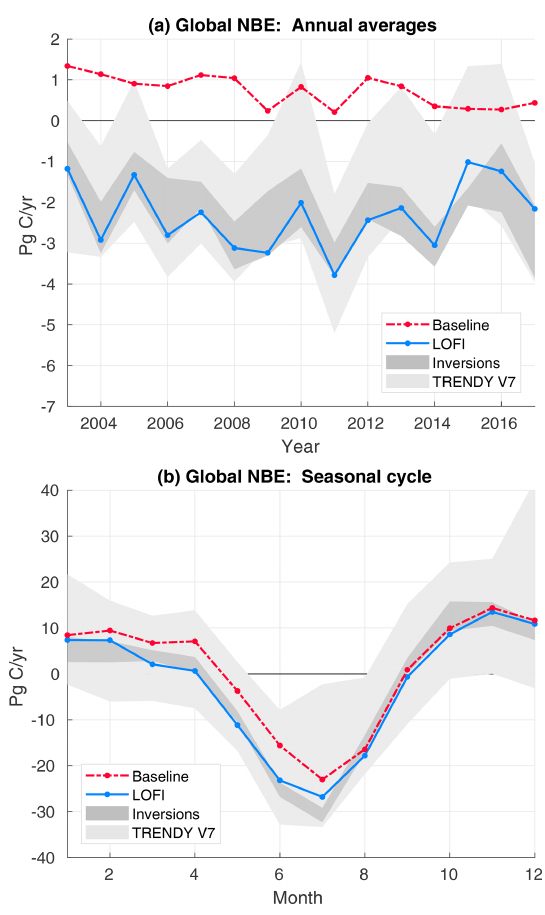
Figure 2. Global total NBE from fluxes excluding (baseline; dash– dot red) and including (LoFI; solid blue) the empirical sink: (a) an- nual averages and (b) the seasonal cycle climatology for 2003– 2015. Minimum-to-maximum ranges of the inversion ensemble (dark grey) and TRENDY V7 ensemble (light grey) are provided for comparison. Table 2. Comparison of 2004–2014 NBE budgets over the northern extratropics (NE) and tropics and southern extratropics (T+SE). Product NE (PgC) T+SE (PgC) Baseline 0 . 07 − 1 . 24 LoFI 2 . 50 − 0 . 41 Inversions a 2 . 27 ± 0 . 36 − 0 . 10 ± 0 . 28 TRENDY V7 a , b 1 . 27 ± 0 . 65 0 . 00 ± 0 .